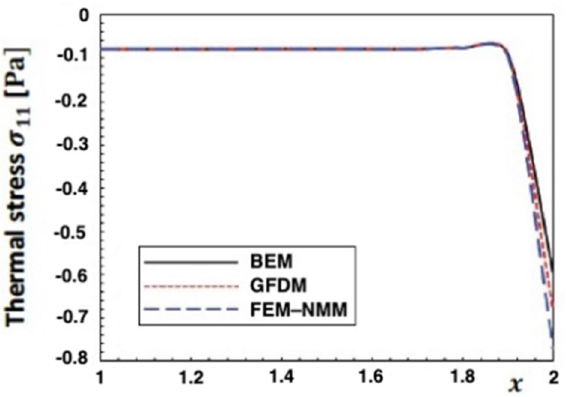
Figure 10. Variation of the special case thermal stress σ 11 along x -axis for BEM, GFDM and FEM–NMM ( a = 0.0, m = 0.6 )